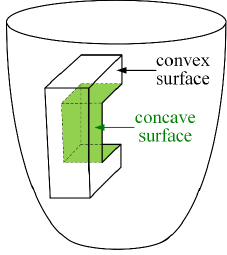
Figure 2. Representation of a mug handle by one convex and one concave